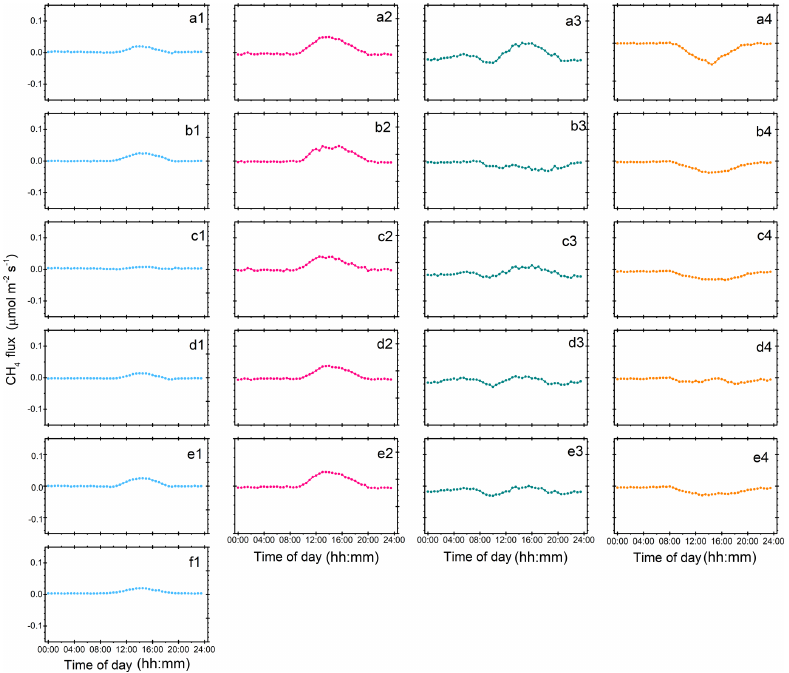
Figure 4. Diel CH 4 fluxes from 2012 to 2016 for different seasons. Blue, pink, green and orange, represent winter, spring, summer, and autumn, respectively: (a1–a4) 2012, (b1–b4) 2013, (c1–c4) 2014, (d1–d4) 2015, (e1–e4) , and (f1)